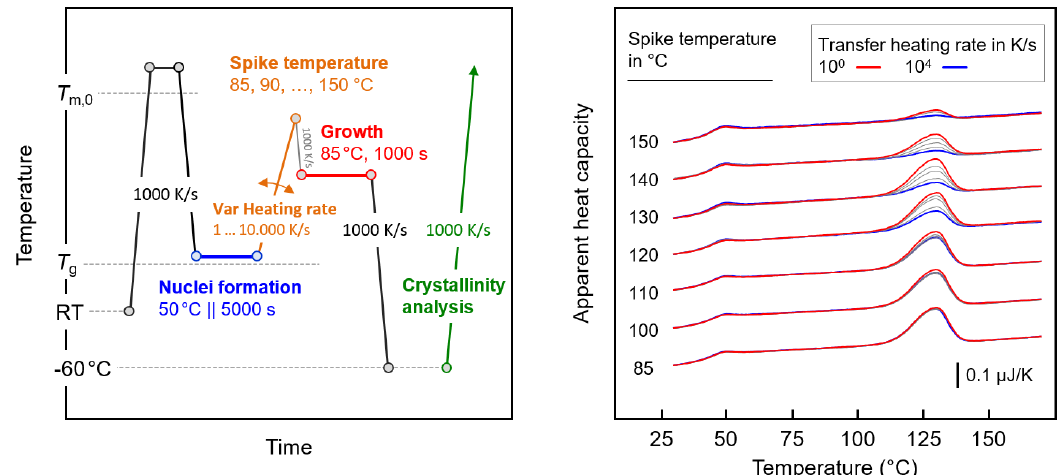
Figure 5. Temperature–time profile for the analysis of the effect of the nuclei-transfer heating rate and spike temperature on nuclei stabilization ( left ). FSC heating curves after subjecting the polymer to nucleation at 50 °C for 5000 s, followed by heating to a pre-defined maximum temperature between 85 and 150 °C at different rates between 1 K/s (red curves) and 10,000 K/s (blue curves), and the growth of nuclei to crystals at 85 °C for 1000 s ( right ).